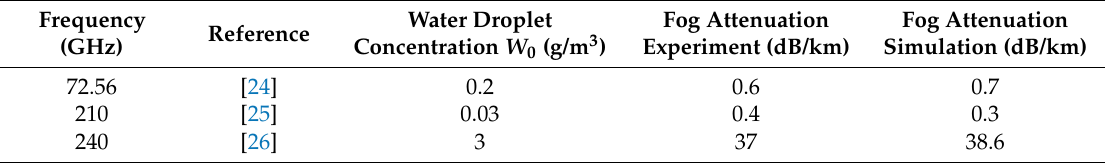
Table 1. Comparison of measured fog attenuation in millimeter wavelengths with previous